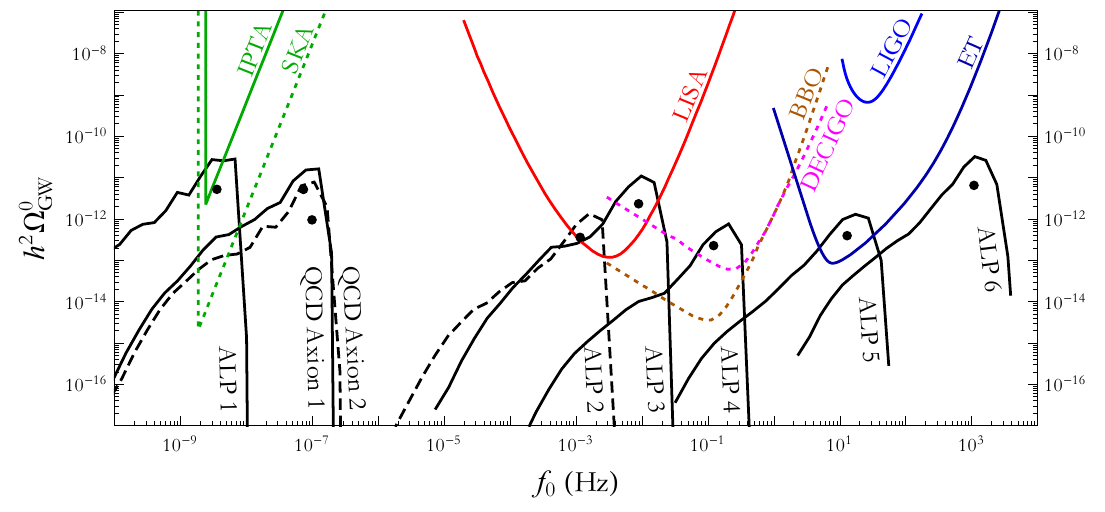
Figure 2 . Black lines give benchmark gravitational wave spectra at the present time for various values of the model parameters (shown in table 1). The black dots show the prediction of the peak location using the scaling relation in eq. (4.12). Colored curves are projected power law sensitivities for various gravitational wave detectors. Green (dotted): IPTA (SKA), Red: LISA 4-yr, Blue: LIGO 2022, Brown: DECIGO, Magenta: BBO, Dark Blue: Einstein